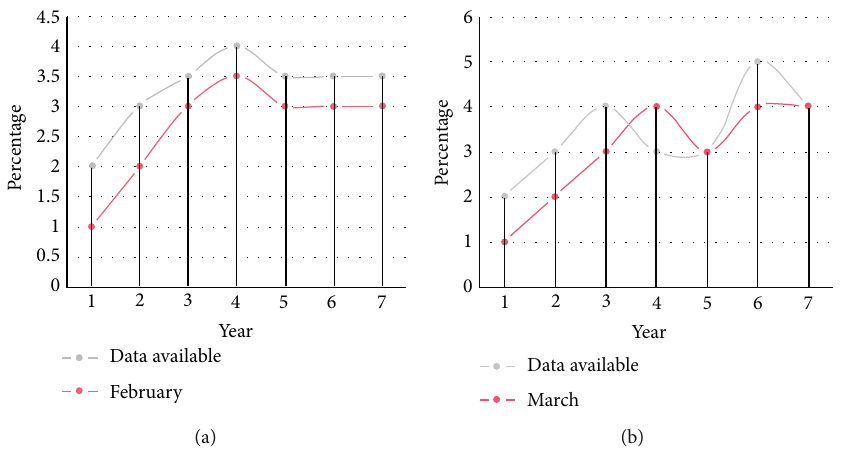
Figure 4: Comparison of data between two model